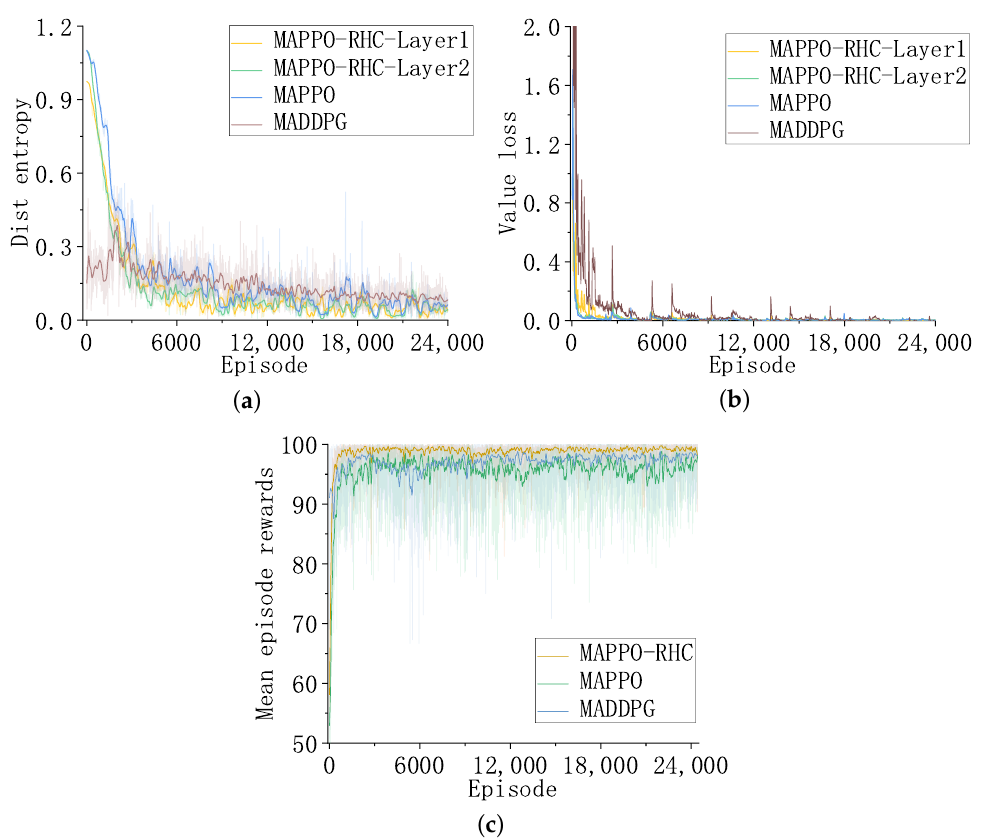
Figure 9. The results of training. ( a ) The distributional entropy of the actor network. ( b ) The loss of value of the critic network. ( c ) The average